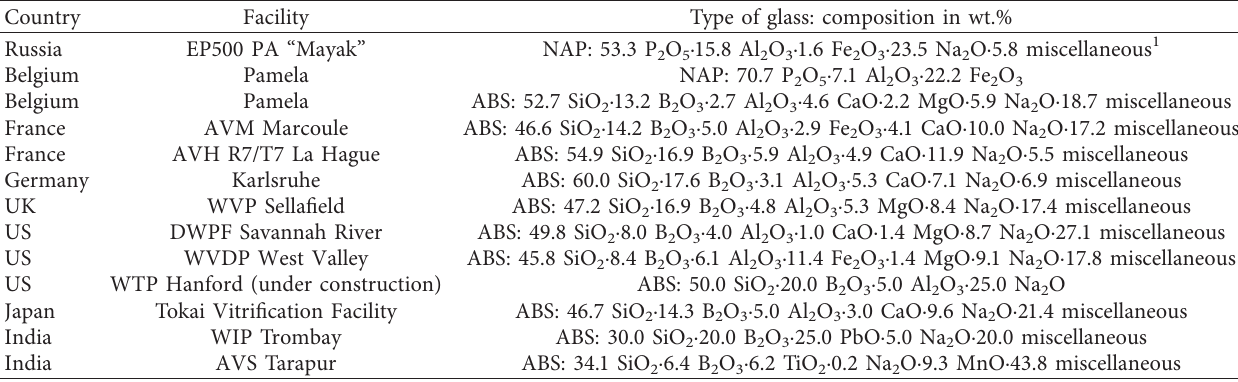
Table 1: HLW industrial immobilization (vitrification) plants [2, 4–16].